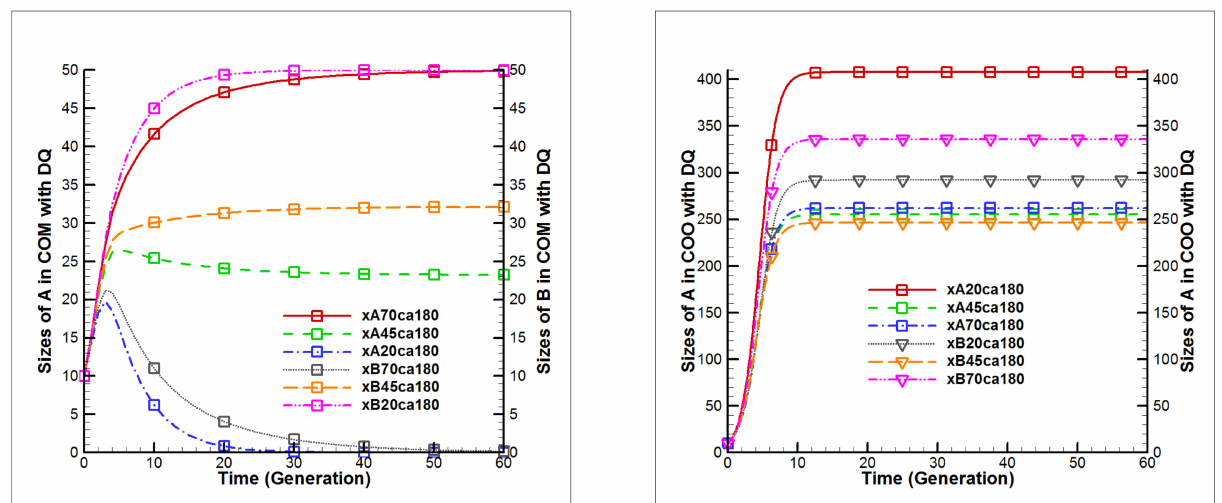
Figure 5. Evolution trajectories for player population sizes in case 3. (Note: ca180 is case 3; 20, 45, and 70 equal different entanglement intensities; Coo and Com are cooperation and competition coexistence, respectively; xA20 and xB20, xA45 and xB45, and xA70 and xB70 are the evolution trajectories of player A and B population sizes with entanglement intensity 20 ◦ , 45 ◦ and 70 ◦ ,